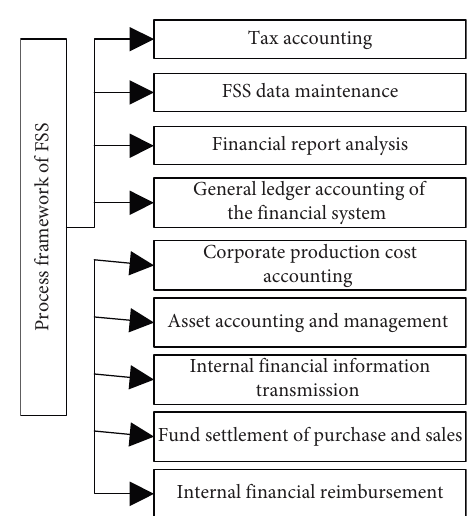
Figure 2: Overall process framework of